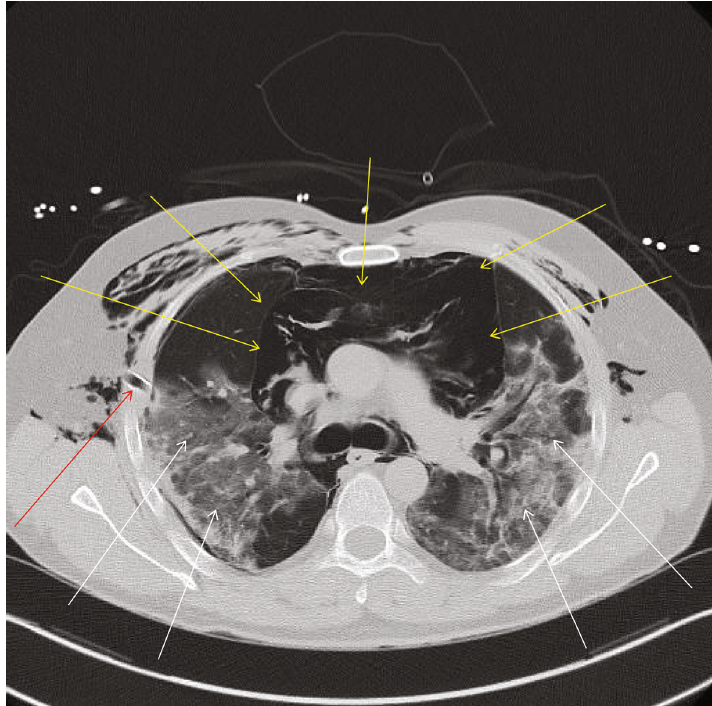
Figure 1: Initial chest CT-scan at the level of tracheal bifurcation directly after transfer to our ICU. The white arrows indicate bilateral ground glass opacities. Yellow arrows display the pneumomediastinum. The red arrow points at the thoracic drainage which was placed during the stay in the referring